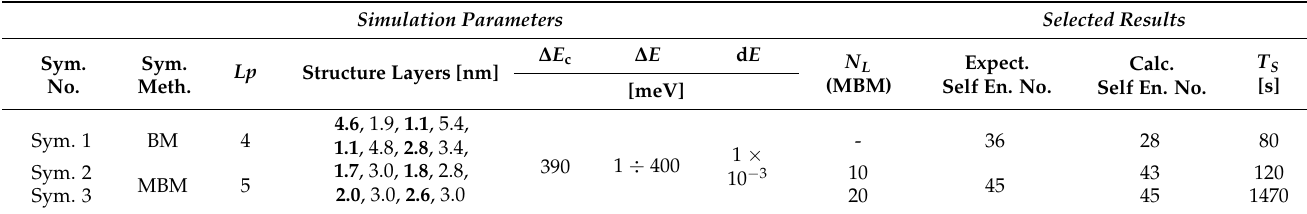
Table 2. Basic parameters and selected simulation results for structure presented in [28]. Simulation Parameters Selected